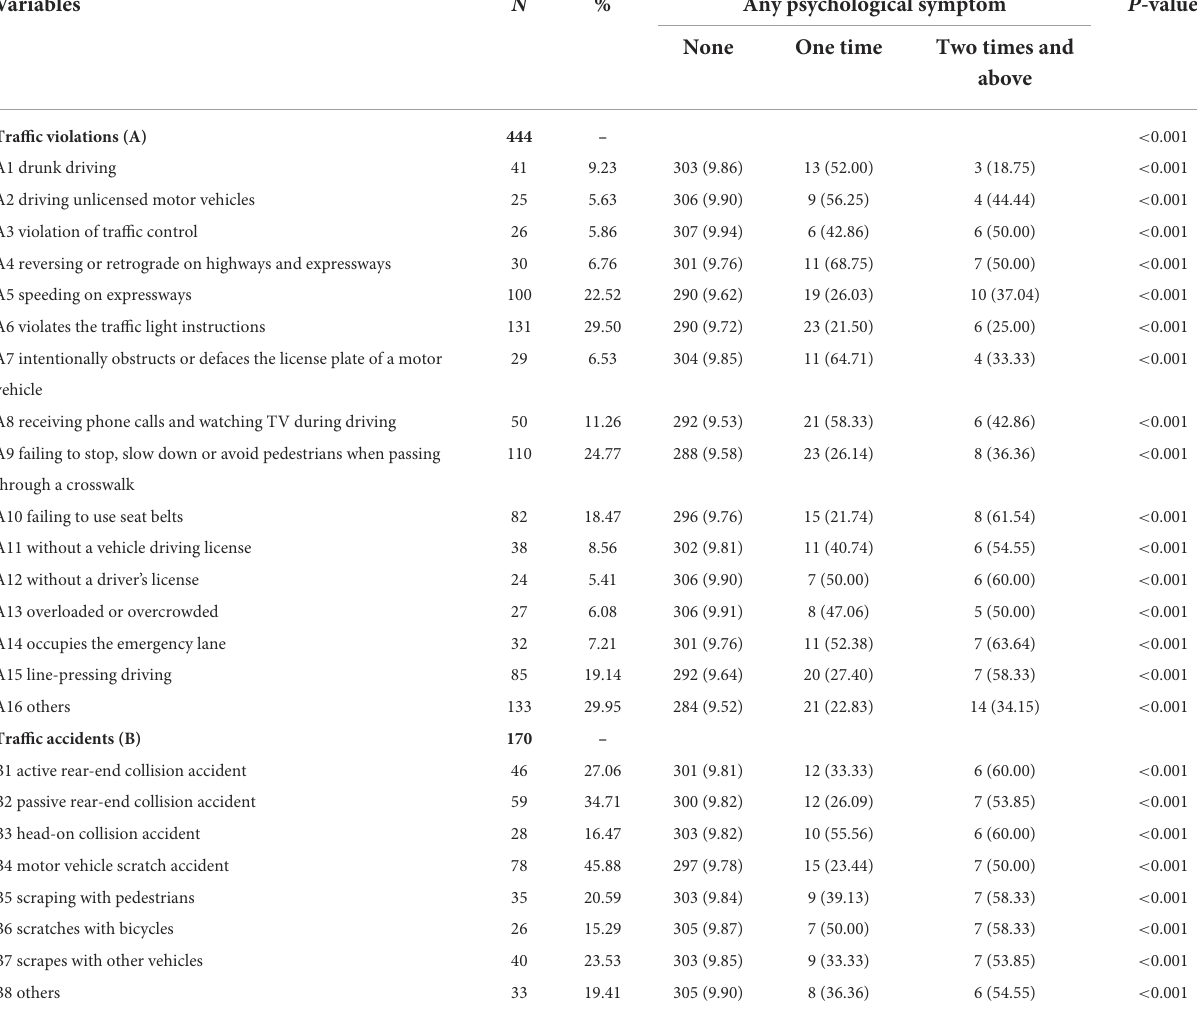
TABLE 7 Prevalence of any psychological symptom among drivers with different frequencies of each traffic violation/traffic accident. Variables N % Any psychological symptom P -value None One time Two times and